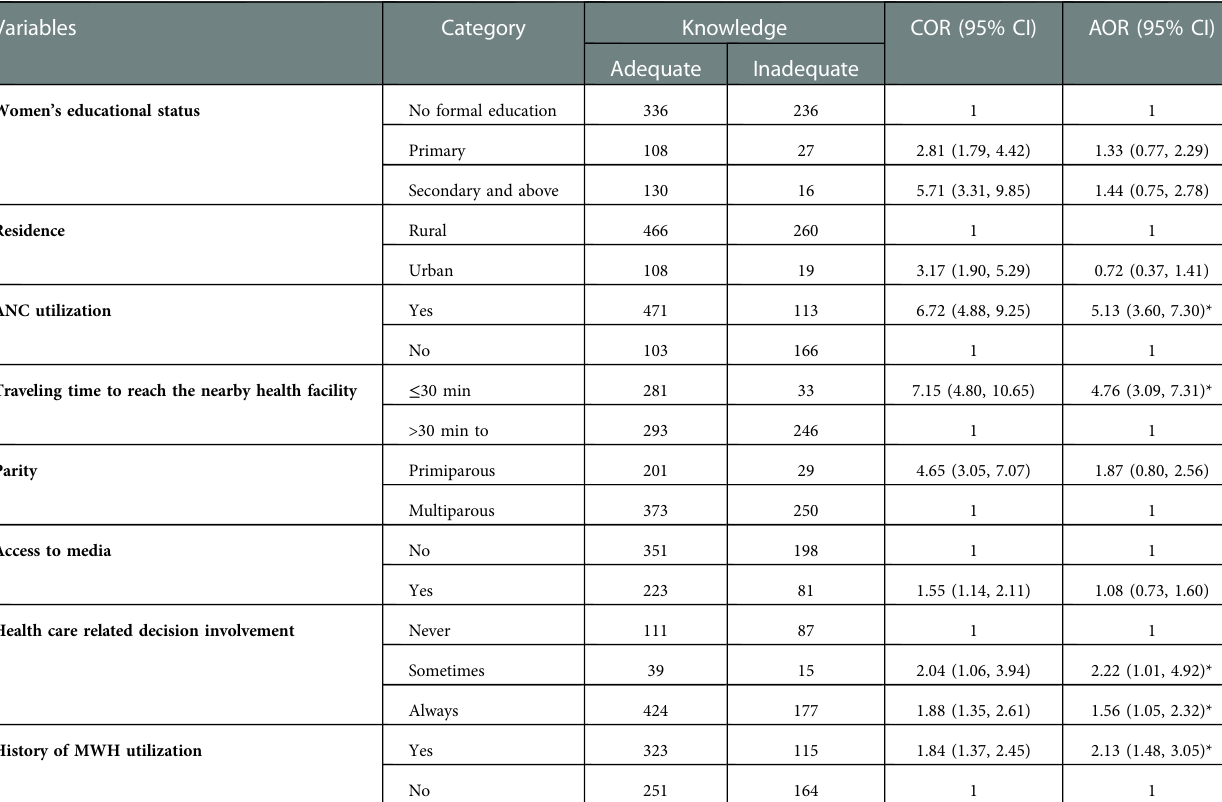
TABLE 5 Multivariable logistic regression analysis of factors associated with knowledge about MWH services in Dega Damot district, northwest Ethiopia, 2021.